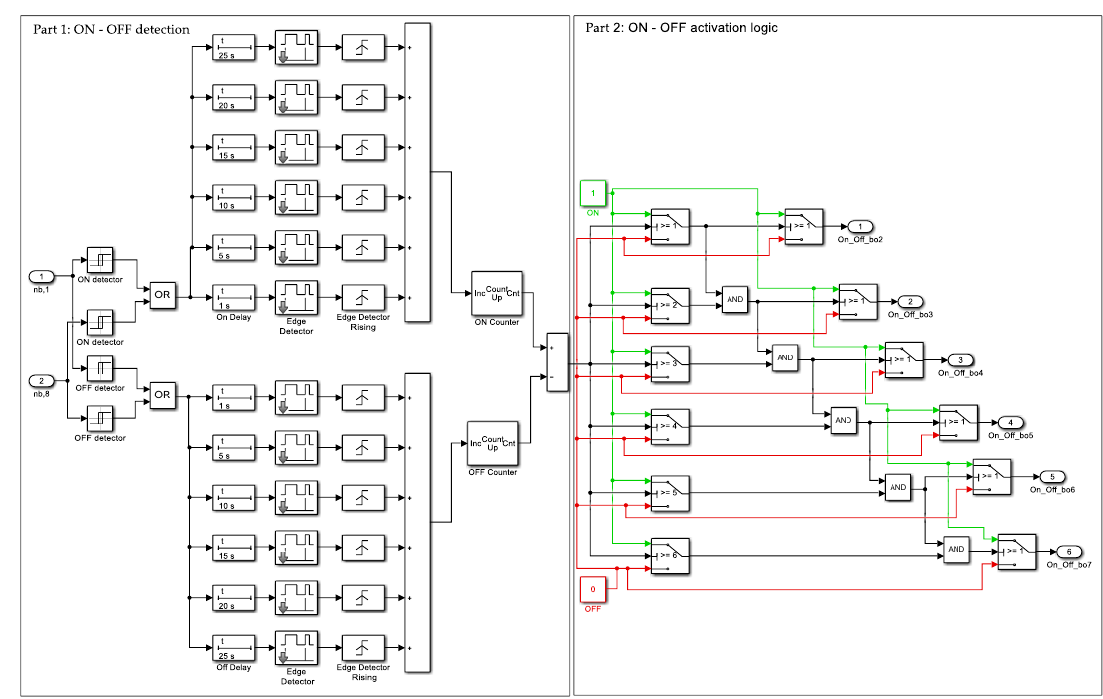
Figure 7. “Discrete Controller Fixed-Speed Pumps” layout.